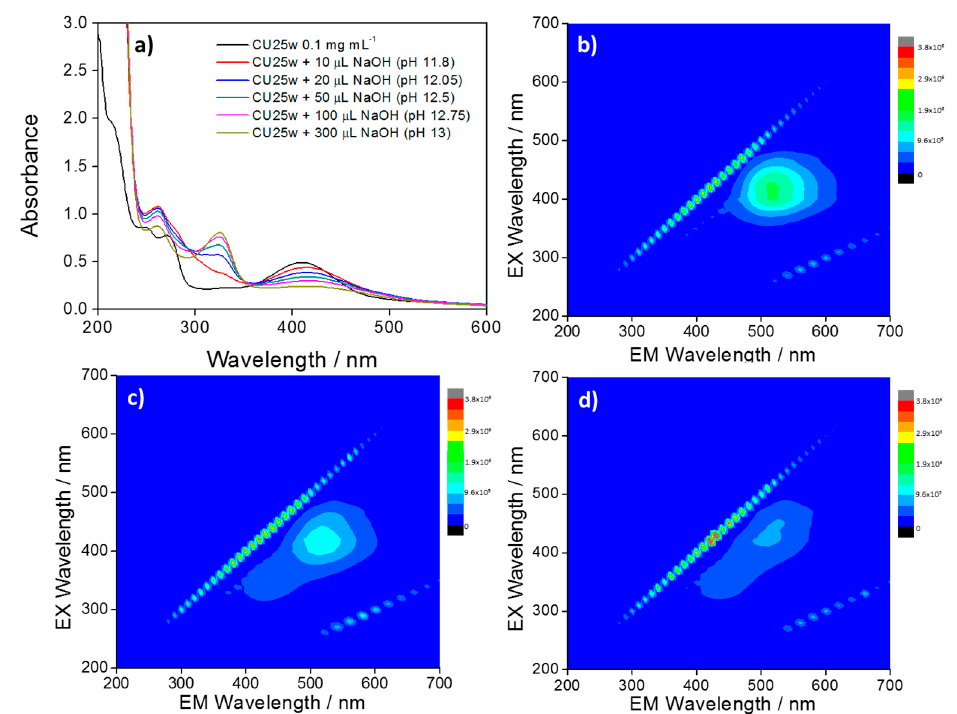
Figure 6. ( a ) UV–Vis spectra of CU25 C-dots (black line) and after consecutive additions of NaOH. 3D photoluminescence spectra (excitation (y-axis), emission (x-axis), intensity (false colors scale) of ( b ) CU25 C-dots in water and after addition of ( c ) 50 μ L and ( d ) 100 μ L NaOH. C-dots concentration = 100 mg L − 1 .